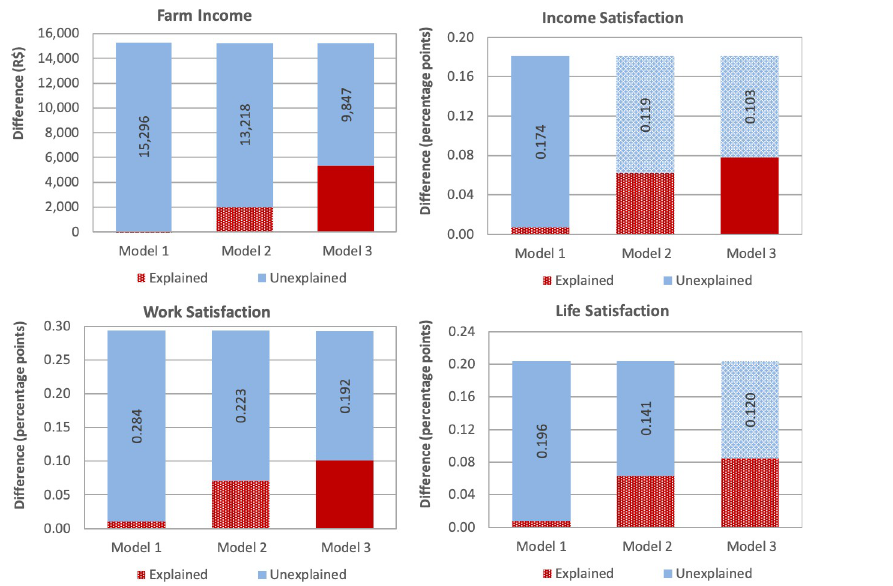
Fig 1. Oaxaca-Blinder decomposition for farm income and subjective wellbeing